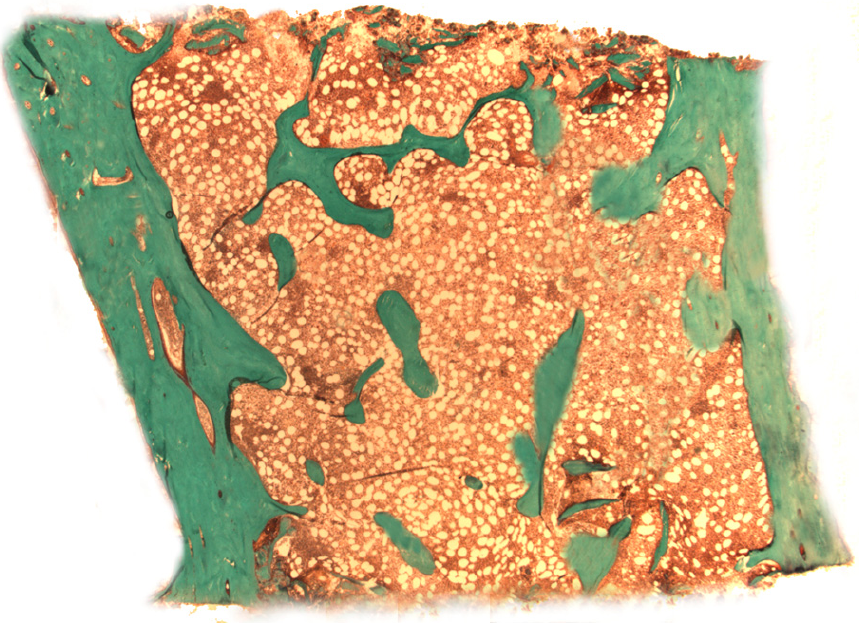
Figure 1. Representation of a Goldner trichrome-stained bone section. In green: the mineralized matrix, in red: the osteoid.